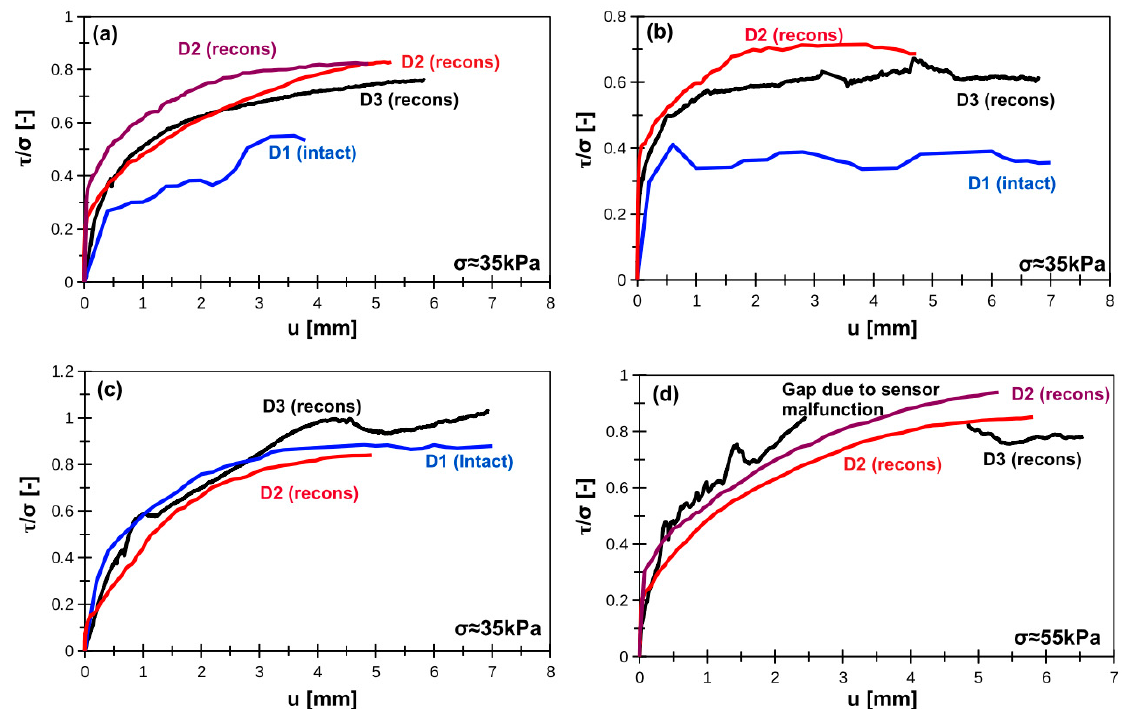
Figure 3. Normalized rough concrete–soil interface shear strength for ( a ) silty loam, ( b ) organic clay, ( c ) peat, ( d ) organic silt. Note: D1, D2, D3 indicate device type; intact = intact sample, recons = reconstituted sample.